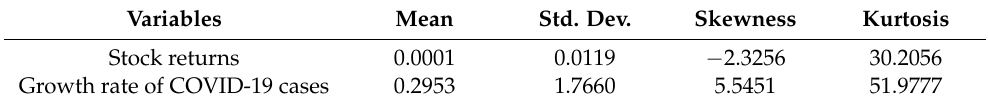
Table 1. Descriptive